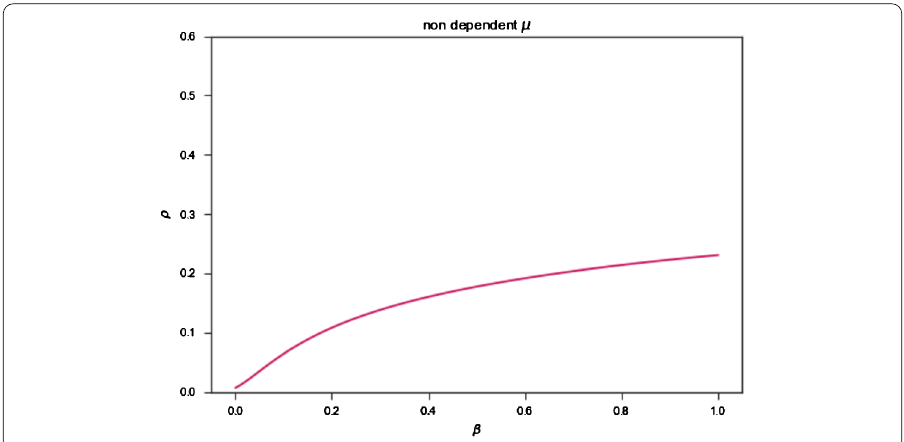
Figure 3 Recoveryratedependenceofthefractionofinfectednodes . ρ ( β , μ ) for the system with the recovery rate μ for all network nodes